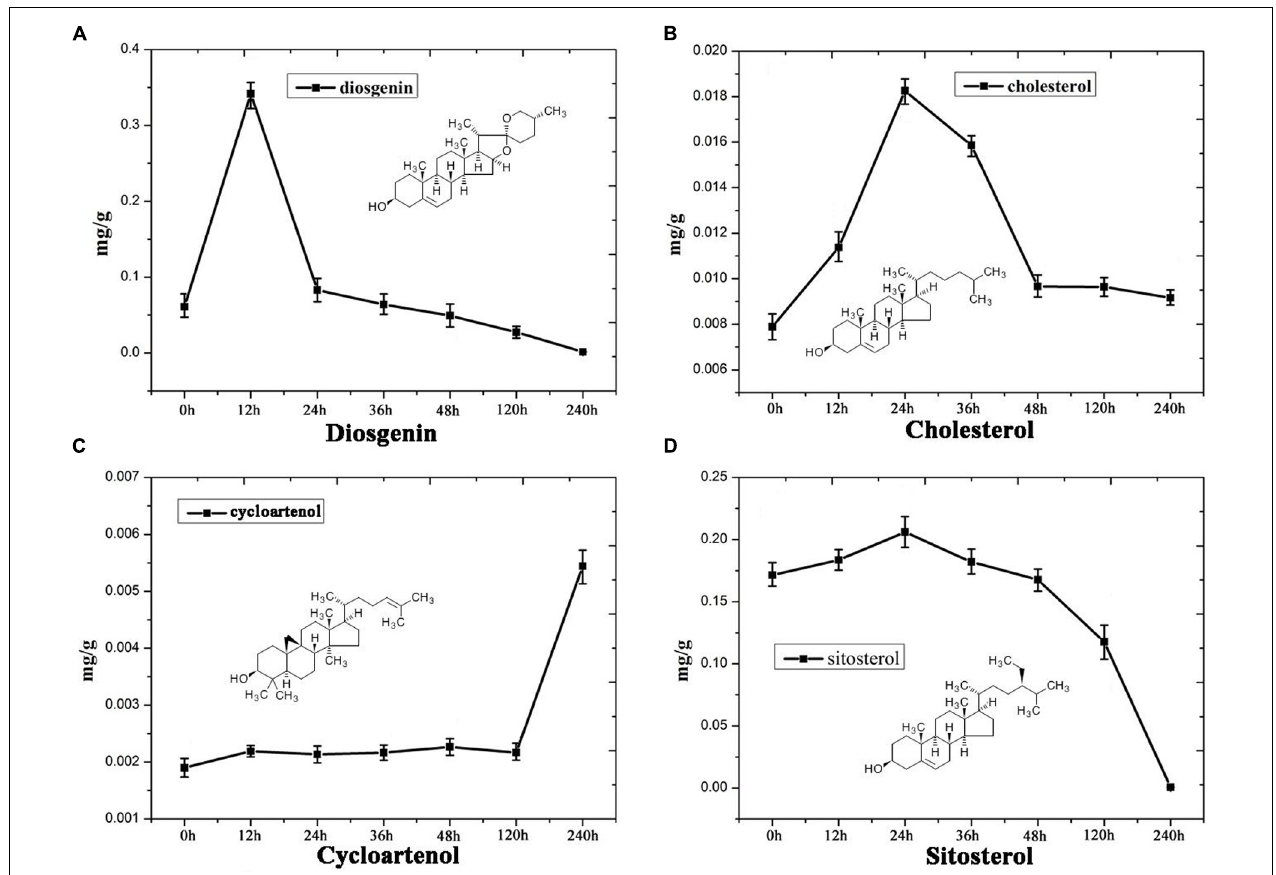
FIGURE 3 | Content analysis showing the levels of (A) diosgenin, (B) cholesterol, (C) cycloartenol and (D) sitosterol in MeJA-treated D. nipponica roots.